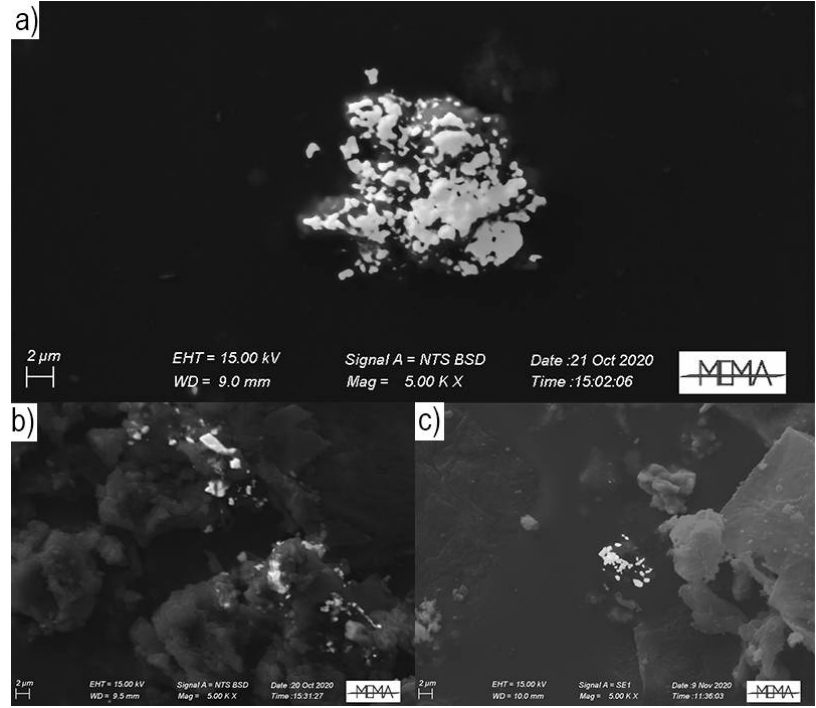
Figure 2. Mix of secondary electron (SE) and backscattered electron (BSE) images of the clusters of Hg-particles found in ( a ) W-OD, ( b ) W-AD and ( c ) W-ND, respectively.